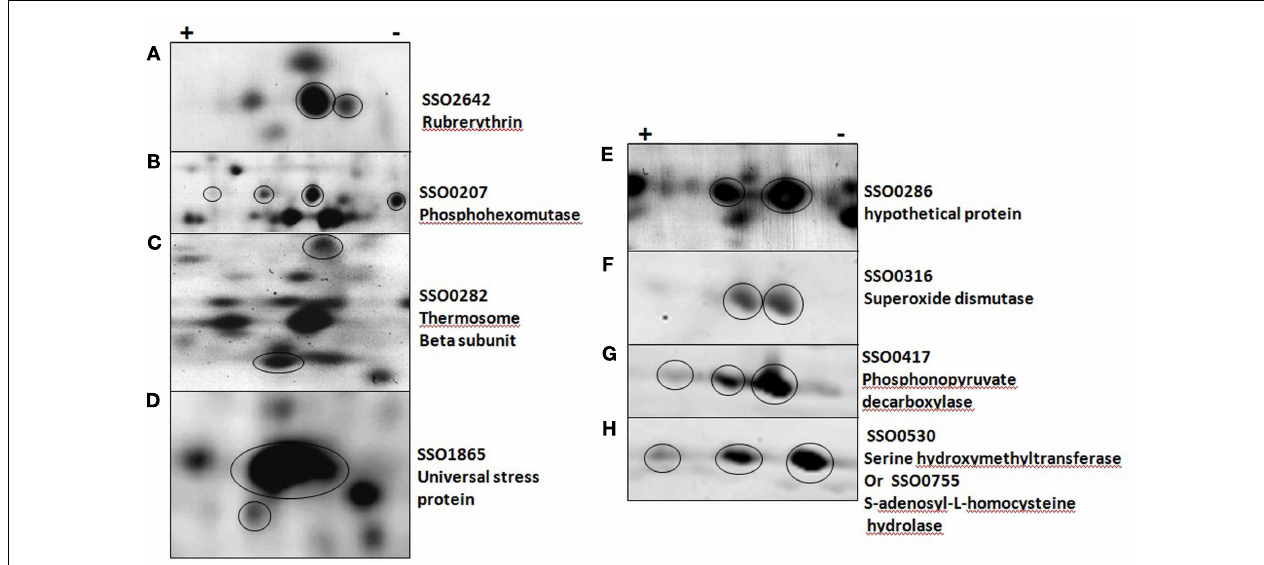
FIGURE 2 | Post-translationally modified proteins in five solfataricus (P2). (A–D) were imaged with a general protein stain, (E–H) with a phosphoprotein specific stain. Circles indicate protein of interest in each